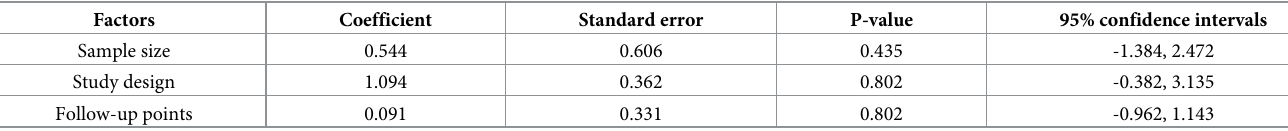
Table 4. Meta-regression analysis of potential sources of heterogeneity.